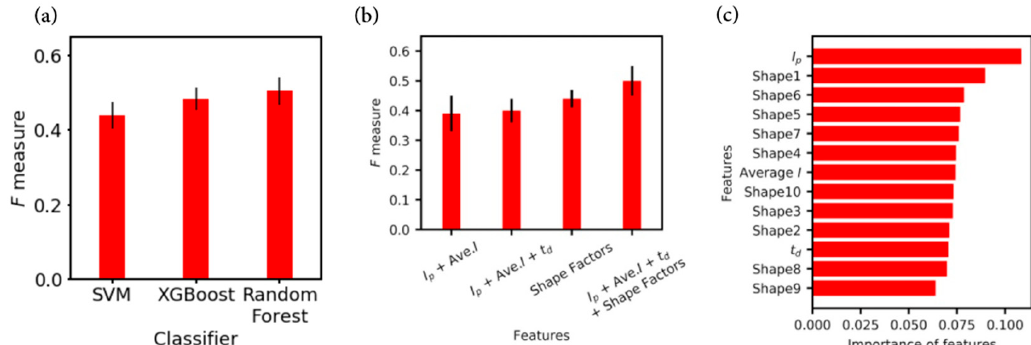
Figure 6. ( a ) Comparison of F-measure values for support vector machine (SVM), extreme gradient boosting (XGBoost), and random forest. The hyperparameters of SVM were determined by a grid search to have the best F-measure. All the algorithms succeeded in identifying with an F-measure of 0.42 or higher. Among several classification algorithms, including SVM and XGBoost, the random forest algorithm had the best discrimination accuracy. Its good discrimination accuracy indicated that all the prepared features ( I p , I ave , t d , S 1 , S 2 , S 3 , S 4 , S 5 , S 6 , S 7 , S 8 , S 9 , and S 10 ) used here were involved in the discrimination. An evaluation was made of the contributions to the discrimination of the different feature parameters. ( b ) Comparison of four sets of feature parameters, i.e., the maximum current value ( I p ), average current value ( I ave ), t d , and shape factors ( S n ). Among the four sets of the parameter combinations, the best combination was found to be maximum current value, average current value, and shape factors ( I p , I ave , t d , S n ). This confirmed that all the prepared features used here were important for the discrimination. In addition, among three sets of feature parameters, I p , t d , and the shape factors, the shape factors ( S n ) were found to provide the highest discrimination accuracy. This suggested that the shape factors were important. ( c ) Estimation of the importance of each feature parameter. The random forest classifier could evaluate the importance of each feature, which was an index of how much the discrimination accuracy decreased when each of the feature parameter was omitted. Among these indexes, two feature parameters, i.e., the maximum current value ( I p ) and first shape factor (S1), were found to be the most important.